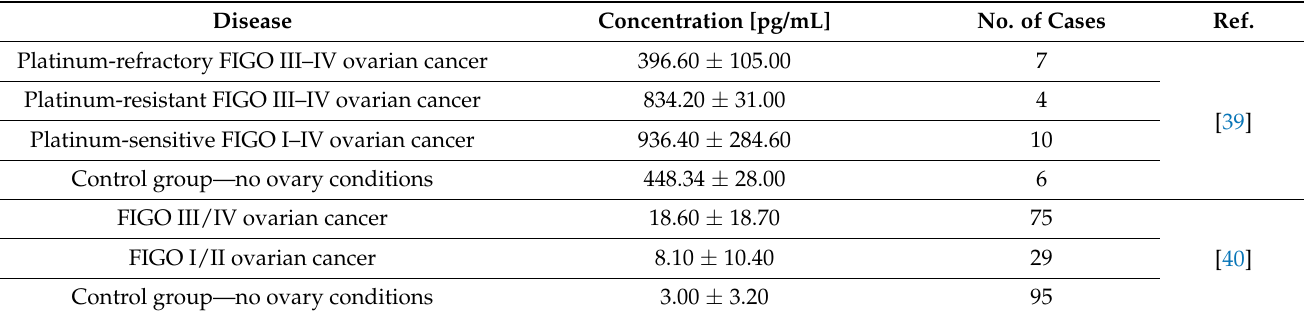
FIGO—The International Federation of Gynecology and Obstetrics. In column 2, the serum concentrations are marked in bold, and the plasma concentrations in normal